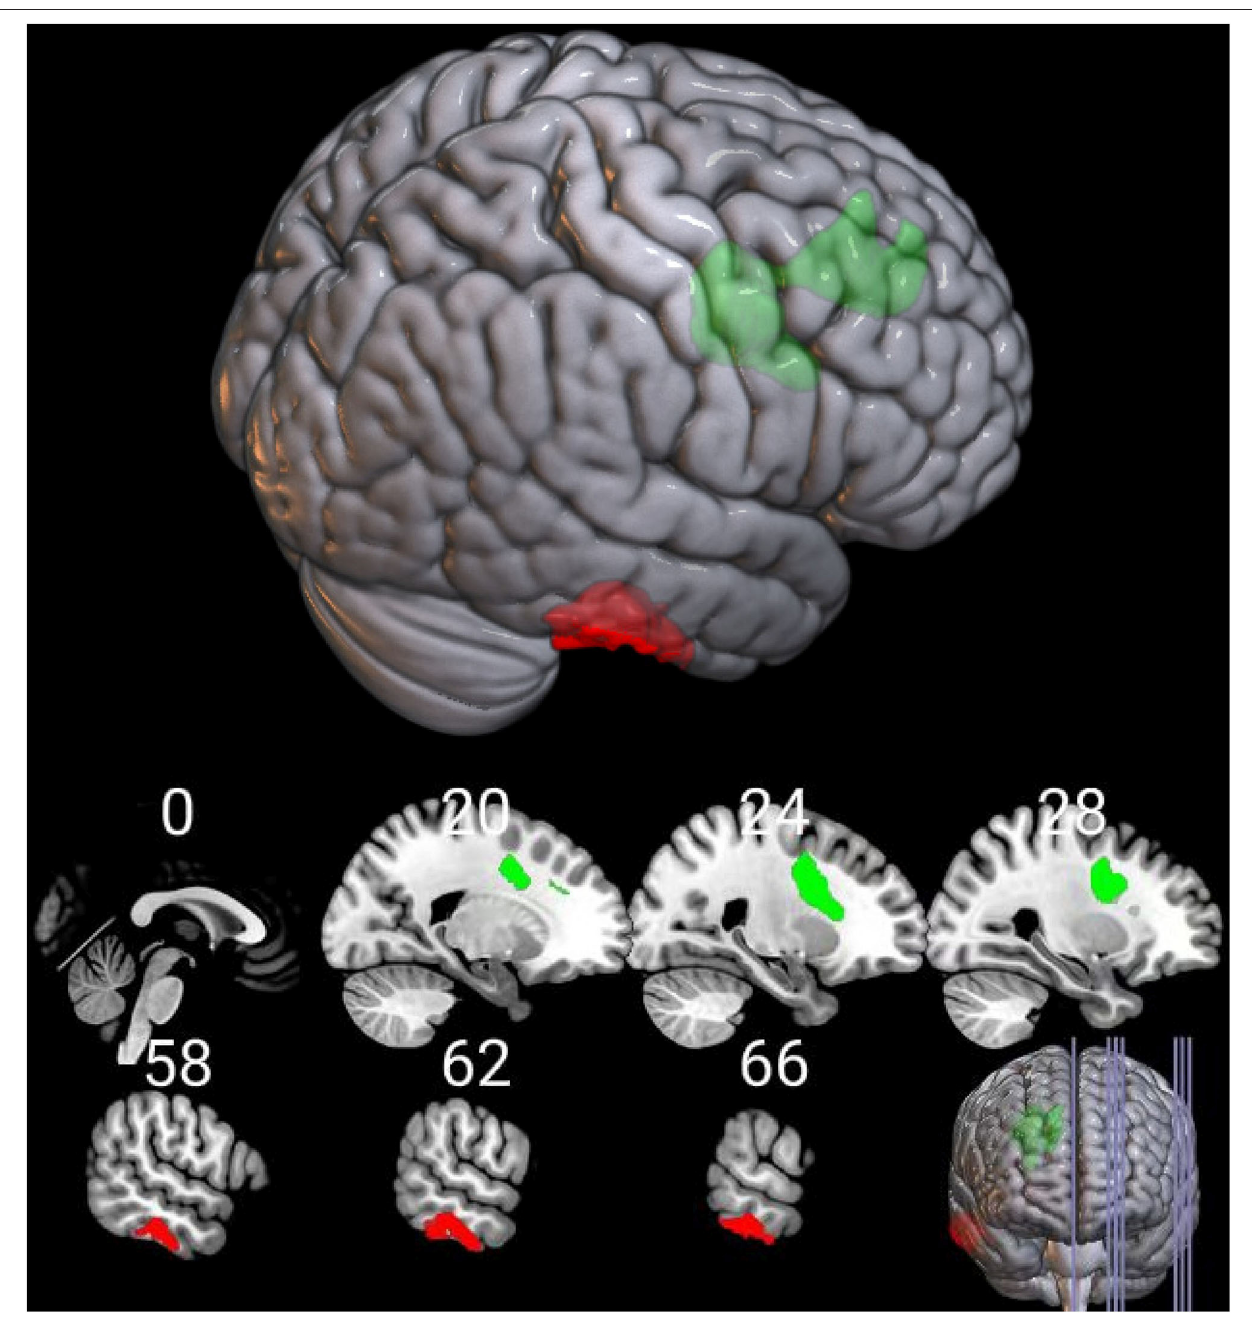
FIGURE 2 | Functional alterations of the deformed brain region in the HIV + group. Functional connection between the deformed right superior frontal region (in green color) and the right inferior temporal gyrus (in red color) was significantly increased in the HIV + group (voxel-level uncorrected P < 0.005, cluster level P < 0.05, FWE